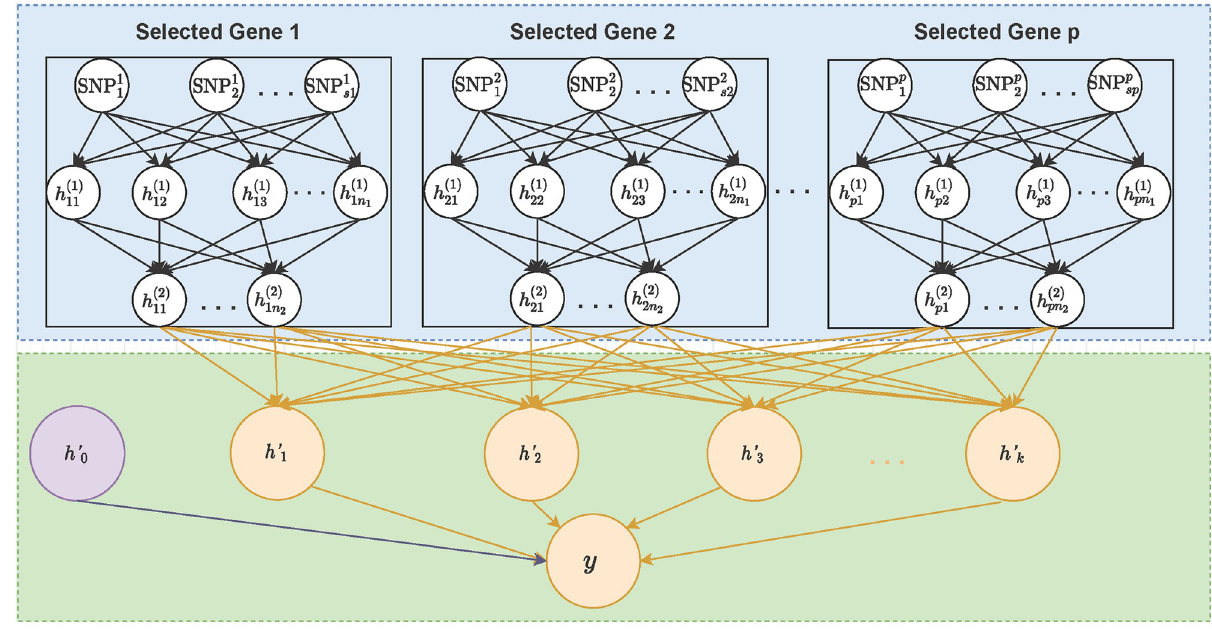
Fig 1. An illustrative figure of the architecture of the proposed transfer-learning-based deep network. The blue box : DNN models obtained from feature screening and the corresponding parameters are fixed. The green box : the background node ( h 0 newly added hidden layers designed to model the joint effects from selected genes. The parameters associated with the background node and the newly added hidden layers are estimated.